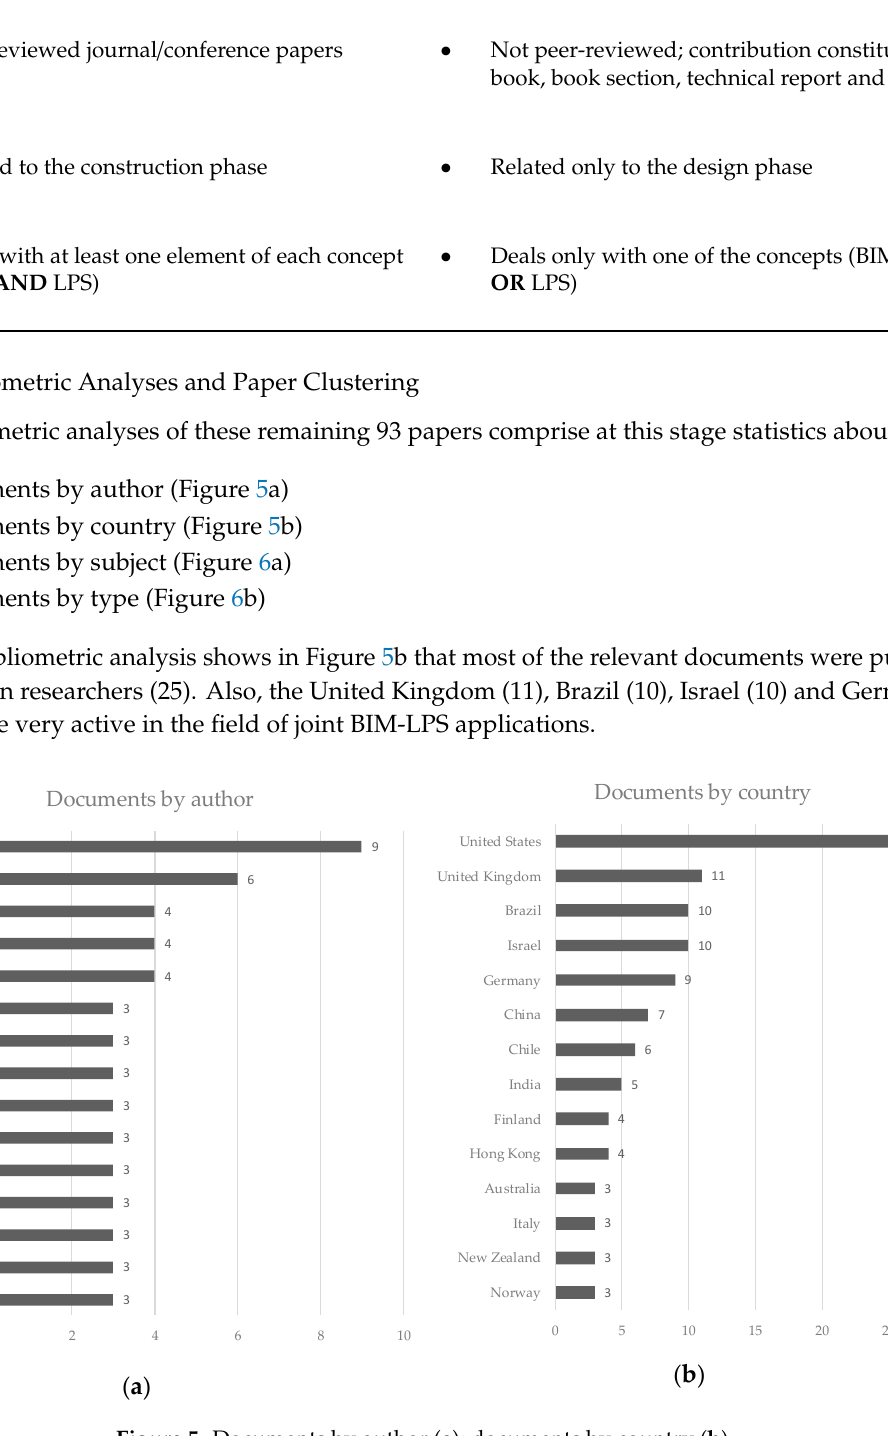
Table 3. Inclusion and exclusion criteria.